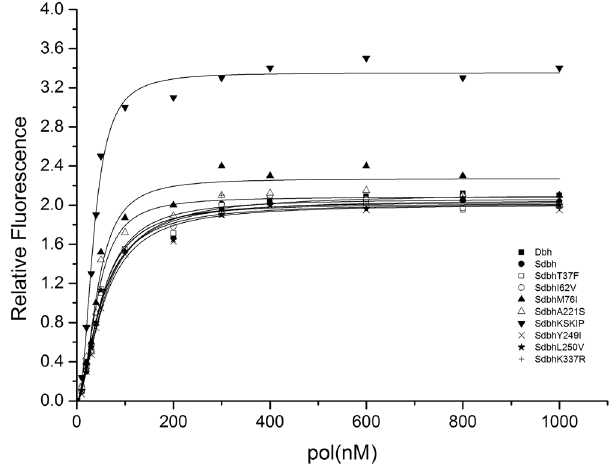
Figure 4. Equilibrium titrations of DNA substrate with Dbh and the variants. A constant amount of 2AP- P/T (100 nM) was titrated with increasing concentration of pol. The fluorescence was excited at 315 nm and observed at 370 nm. Each measurement was repeated four times, and the average value of the fluorescence intensity was recorded. A control experiment was performed with the non-fluorescent promoter DNAs under identical conditions. The fluorescence changes from the control experiments were subtracted from the data obtained with the 2AP-P/T, and the corrected values are plotted against [pol]. The analysis of the data yielded the dissociation constant K d for Dbh( ◾ ), Sdbh( ⚫ ), SdbhT37F( ◽ ) SdbhI62V( ○ ) SdbhM76I( ▴ ), SdbhA221S( ▵ ),